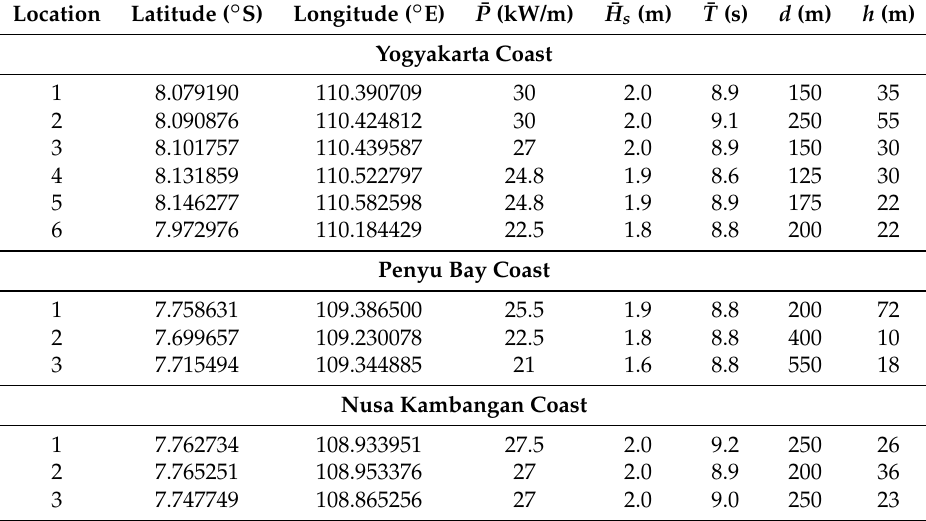
Figure 9. Polar diagrams of yearly significant wave height for the prospective locations in Yogyakarta coast where Y1 to Y6 represent pin locations number 1 to number 6. Table 2. Prospective WEC locations with the estimated mean wave power based on the 15-year assessment along the Yogyakarta, Penyu Bay, and Nusa Kambangan